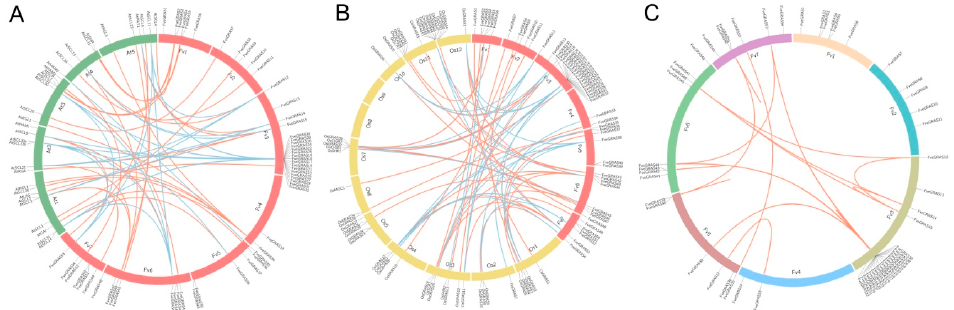
Figure 3. Orthologs, co-orthologs and paralogs of GRAS genes from woodland strawberry, Arabidopsis thaliana and rice. ( A ) Orthologs and co-orthologs of GRAS genes between Arabidopsis thaliana and woodland strawberry. ( B ) Orthologs and co-orthologs of GRAS genes between rice and woodland strawberry. ( C ) Paralogs of GRAS genes in woodland strawberry. OrthoMCL was used to identify orthologs, co-orthologs and paralogs. Red, green and yellow boxes in ( A ) and ( B ) represent chromosomes of woodland strawberry, Arabidopsis thaliana and rice. Red and blue lines in ( A ) and ( B ) represent orthologous and co-orthologous gene pairs. Different color boxes in ( C ) represent the seven chromosomes of woodland strawberry, and red lines in ( C ) represent paralogous gene pairs. The distribution of orthologs, co-orthologs and paralogs of GRAS genes are presented in Supplementary Tables S3 and S4.